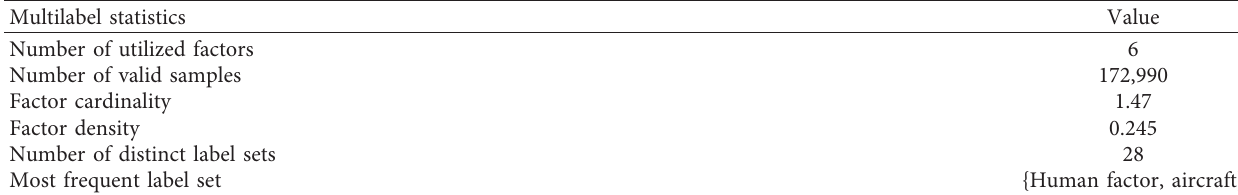
Table 4: Important statistics about the utilized ASRS data